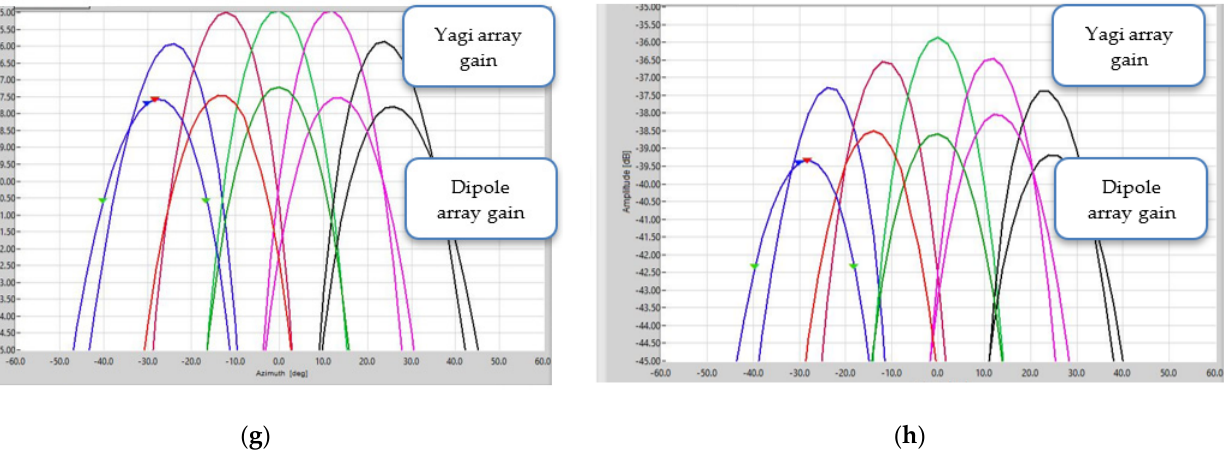
Figure 17. ( a ) Azimuth feed network setup; ( b ) Elevation feed network setup; ( c ) Azimuth gain of dipole array with azimuth scanning; ( d ) Elevation gain of dipole array with elevation scanning; ( e ) Azimuth gain of the Yagi–Uda array with azimuth scanning; ( f ) Elevation gain of the Yagi–Uda array with elevation scanning; ( g ) Azimuth gain comparison of the Yagi–Uda and dipole arrays at 2.3 GHz with scanning; ( h ) Azimuth gain comparison of the Yagi–Uda and dipole arrays at 2.45 GHz with scanning. Table 6. Array